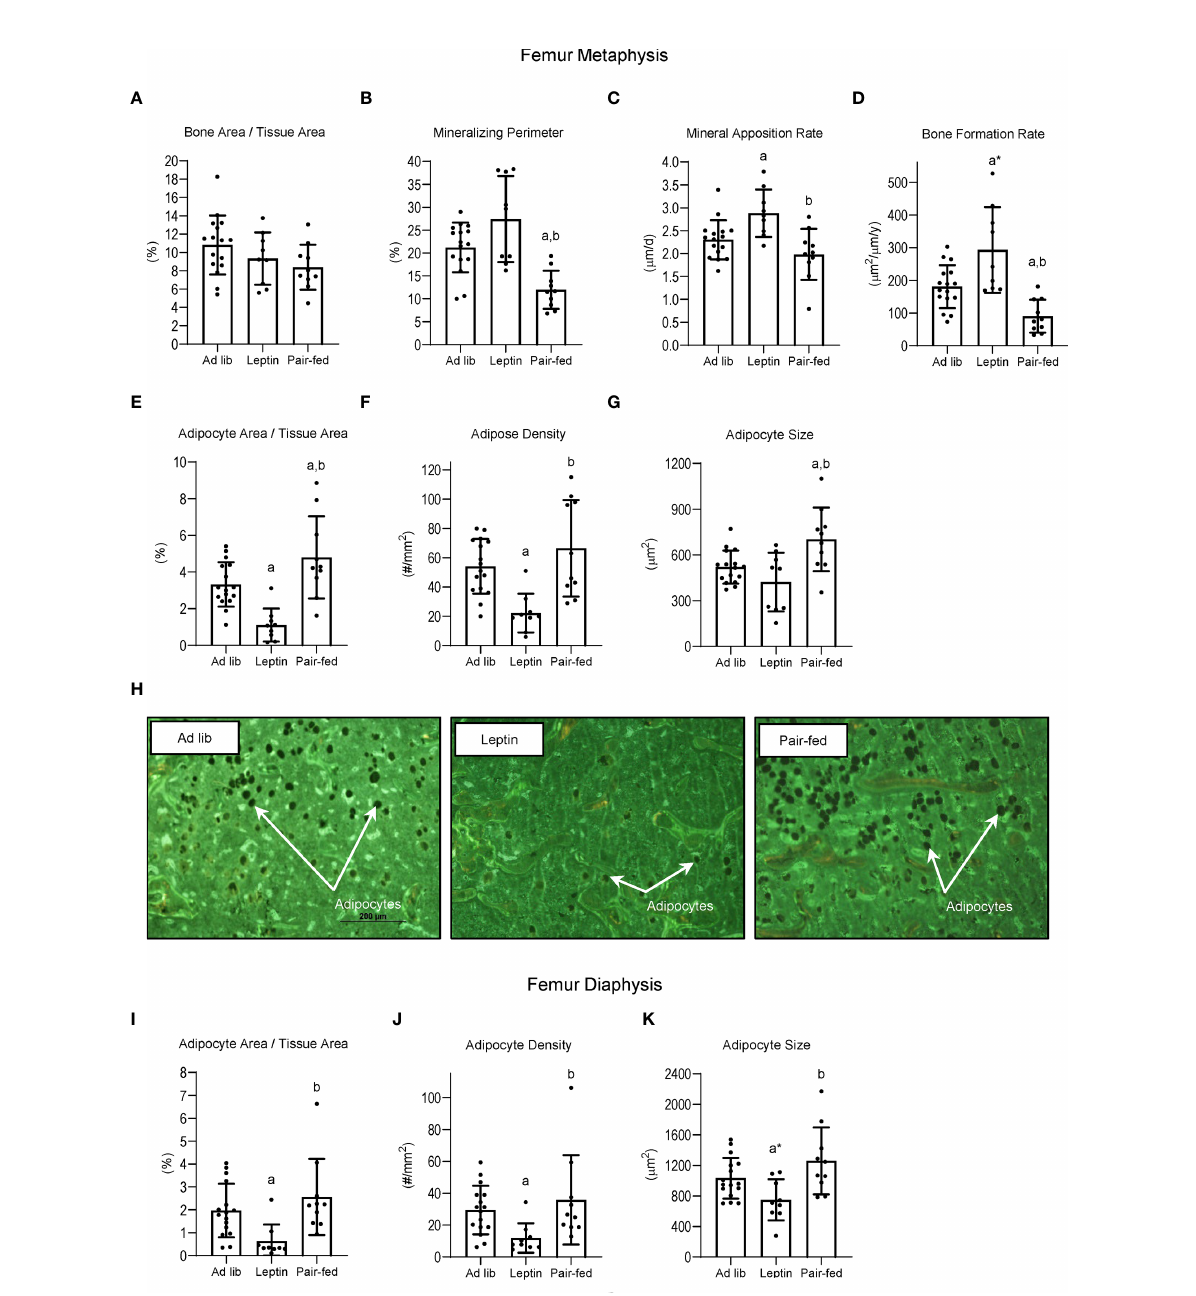
FIGURE 4 Effects of leptin supplementation and pair feeding on bone area and indices of bone formation, bone resorption, and bone marrow adiposity in distal femur metaphysis and on indices of bone marrow adiposity in distal femur diaphysis: bone area fraction (bone area/tissue area) (A) , mineralizing perimeter (B) , mineral apposition rate (C) , bone formation rate (D) , adipocyte area fraction (E) , adipocyte density (F) , and adipocyte size (G) in distal femur metaphysis and adipocyte area fraction (I) , adipocyte density (J) , and adipocyte size (K) in distal femur diaphysis in C57BL/6J female mice. Representative images of the bone marrow adiposity in femur metaphysis in each treatment group are shown in panel (H) Data are mean ± SD with individual data points shown as dots. N = 9-16/group. Analysis of variance followed by appropriate posthoc tests was used to assess differences among groups. a Different from ad lib , FDR-adjusted P < 0.05; a *P < 0.1. b Different from leptin, FDR-adjusted P <